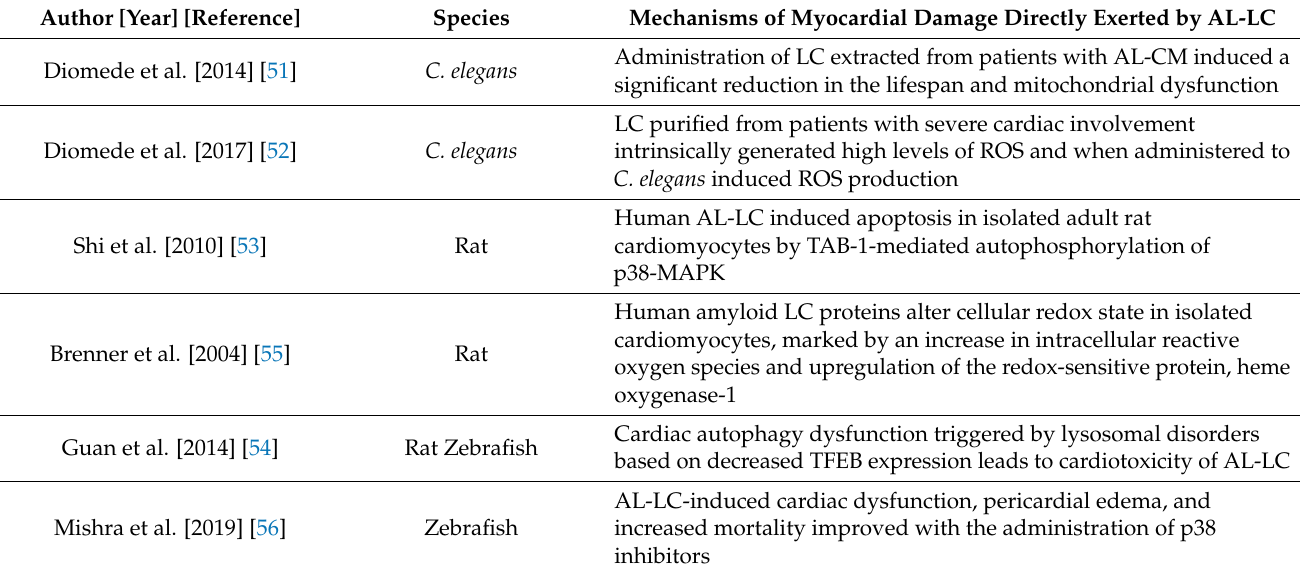
Table 1. Molecular mechanism for AL